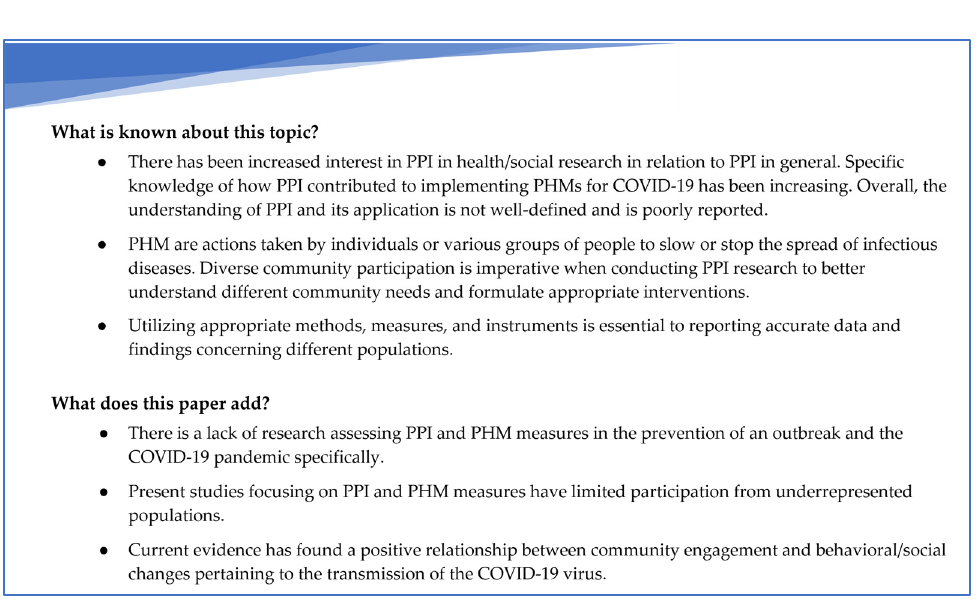
Figure 2. Summary of the existing knowledge on patient and public involvement (PPI) in health and social research and contributions of this umbrella review to it . social research and contributions of this umbrella review to